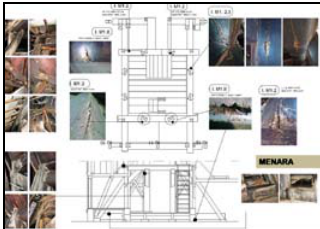
Figure 5. Drawing sample of elements and structural diagnosis and analysis, PDA project for Jakarta Historic